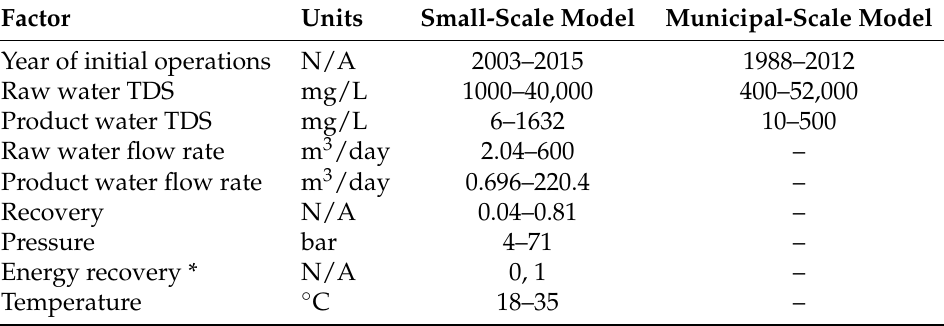
Table 2. Different desalination factors, with ranges in observed values as noted, were used as explanatory variables in the small-scale and municipal-scale models of specific energy